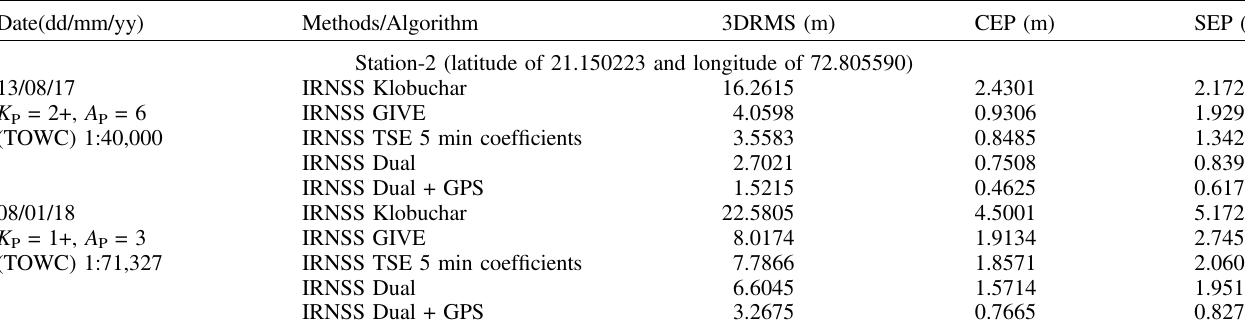
Table 2. The statistical positional error analysis at rover station 2. Date(dd/mm/yy)